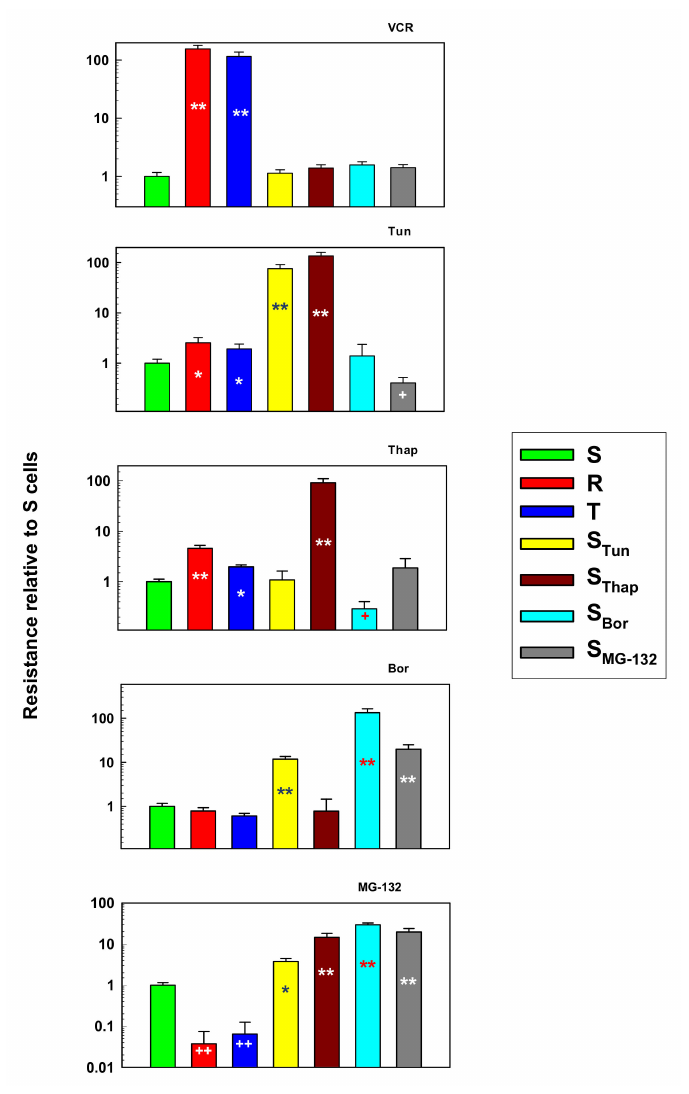
Figure 1. Sensitivities of S, R, T, S Tun , S Thap , S Bor and S MG-132 cells to vincristine (VCR), tunicamycin (Tun), thapsigargin (Thap), bortezomib (Bor), and MG-132. Cells were cultivated for two days in the presence of these substances in a concentration range of 10 -4 –10 µ M, and the LC 50 values were calculated according to Equation (1) (See the Section 4). Data are expressed relative to the LC 50 value for S cells, which was arbitrarily set as one. Cell survival was measured by the MTT test. Data represent the calculated value ± S D for 27 degrees of freedom. Significance: * and ** significantly higher than the value obtained for S cells at p < 0.02 and p < 0.002, respectively. + and ++ significantly lower than the value obtained for S cells at p < 0.05 and p < 0.01,